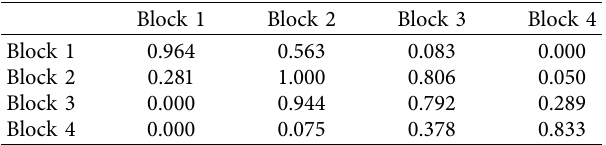
Table 3: Density matrix of the blocks.